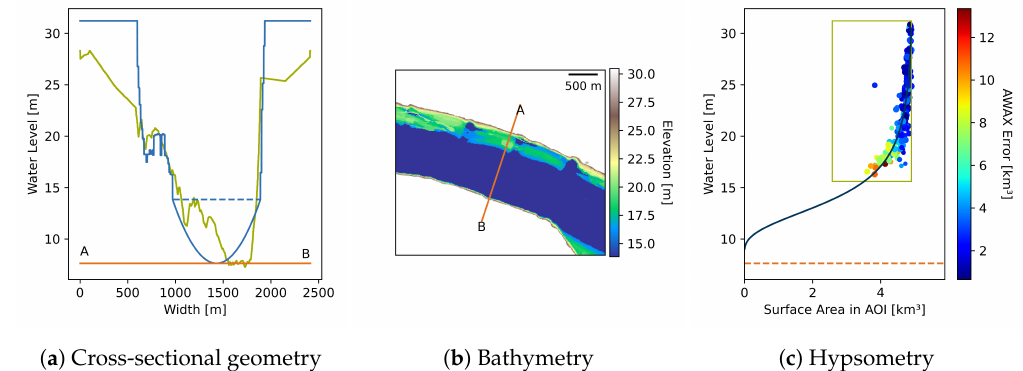
Figure 8. Estimated geometry, bathymetry, and hypsometry upstream of the Vicksburg Gauge (CS 721.1). The blue line in ( a ) shows the estimated and the green line the in situ cross-sectional geometry. Additionally, the figure shows the predicted bed elevation h 0 (orange) and minimum observed water level h b (dashed blue). The bathymetry ( b ) is shown within the AOI defined by the CS which is represented by the orange line. The hypsometry ( c ) was used to construct the bathymetry. The dashed orange line represents h 0 which was used as boundary condition to fit the hypsometric function (dark blue) to the synchronized observations. The color of the observations shows the surface area error within the entire land-water mask not limited to the AOI. The green rectangle shows the bounds of the entire available water level and surface area